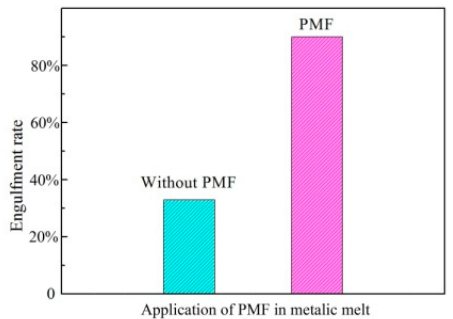
Figure 6. Histogram of engulfment rate from 1600 ◦ C to 1499 ◦ C without and with PMF. Inclusions in the field of view from 1600 ◦ C to 1499 ◦ C were counted. The statistical result is shown in Figure 6. The inclusion engulfment rate in PMF is about three times the case without PMF. In summary, the application of PMF in the solidification process improves the probability of inclusion engulfment. With the aim of revealing the effect of PMF on solidification microstructure, a further microscopy study using a DMI5000M optical microscope was conducted. After grinding and polishing, the specimens were etched with a solution of 96 mL ethanol and 4 mL nitric acid. Phases can be easily distinguished from the matrix because they present different contrasts under optical microscopy. The white phase is ferrite islands, and the gray phase is pearlite. Ferrite laths were mainly precipitated at the grain boundary, a few acicular ferrites and massive ferrites were precipitated inside the grain, and the grain boundaries were coarse (as shown in Figure 7a). After the PMF was applied, more ferrites were precipitated inside the grain, and most of them were acicular, fine and cross-interlocked; the grain boundaries were clear and sharp, as shown in Figure 7b. The result indicates that the application of PMF largely promotes intra-granular ferrite nucleation